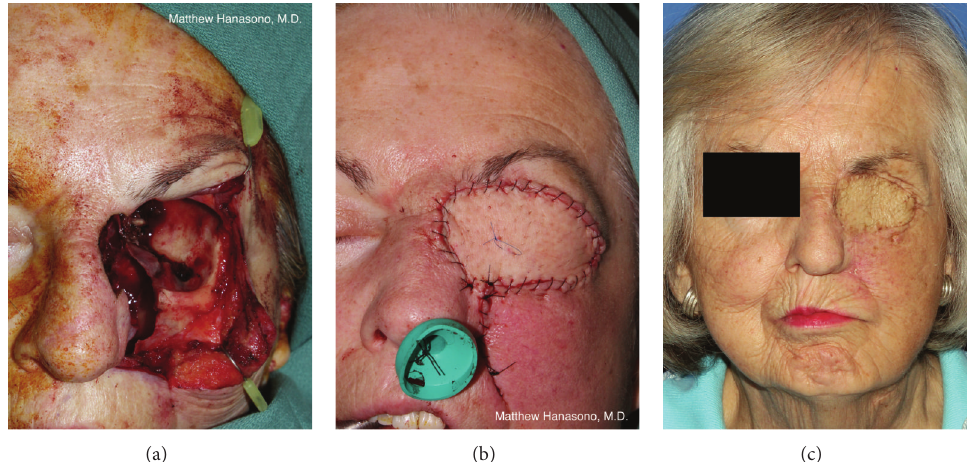
Figure 3: Orbitomaxillectomy defect following tumor removal (a). An anterolateral thigh free flap is used to close the defect and isolate the orbital cavity from the sinonasal cavities (b). A soft nasal trumpet is used to stent the nasal cavity open. Postoperative appearance